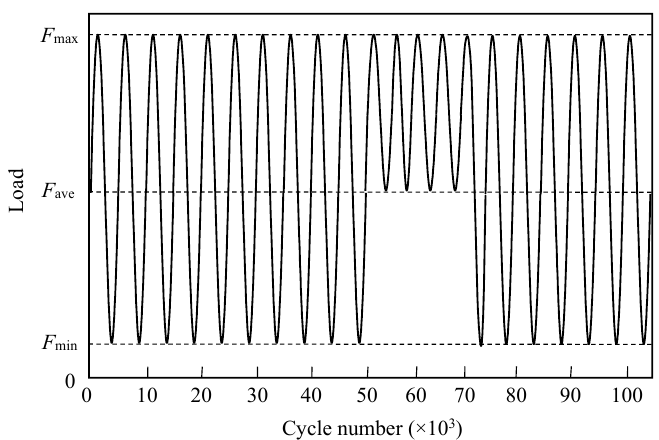
Figure 3. Load spectrum of the “beach marking” technique.